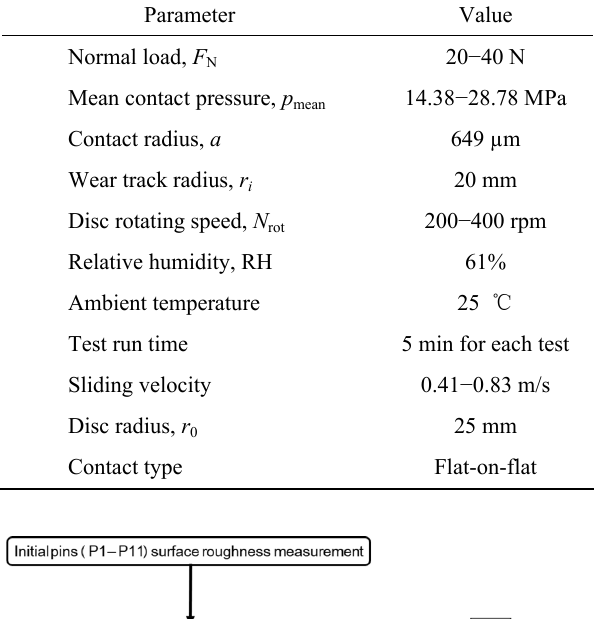
Table 2 Experimental conditions for friction tests.